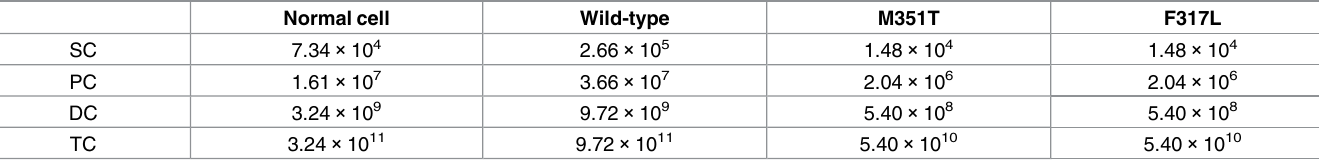
Table 5. The initial cell abundance.